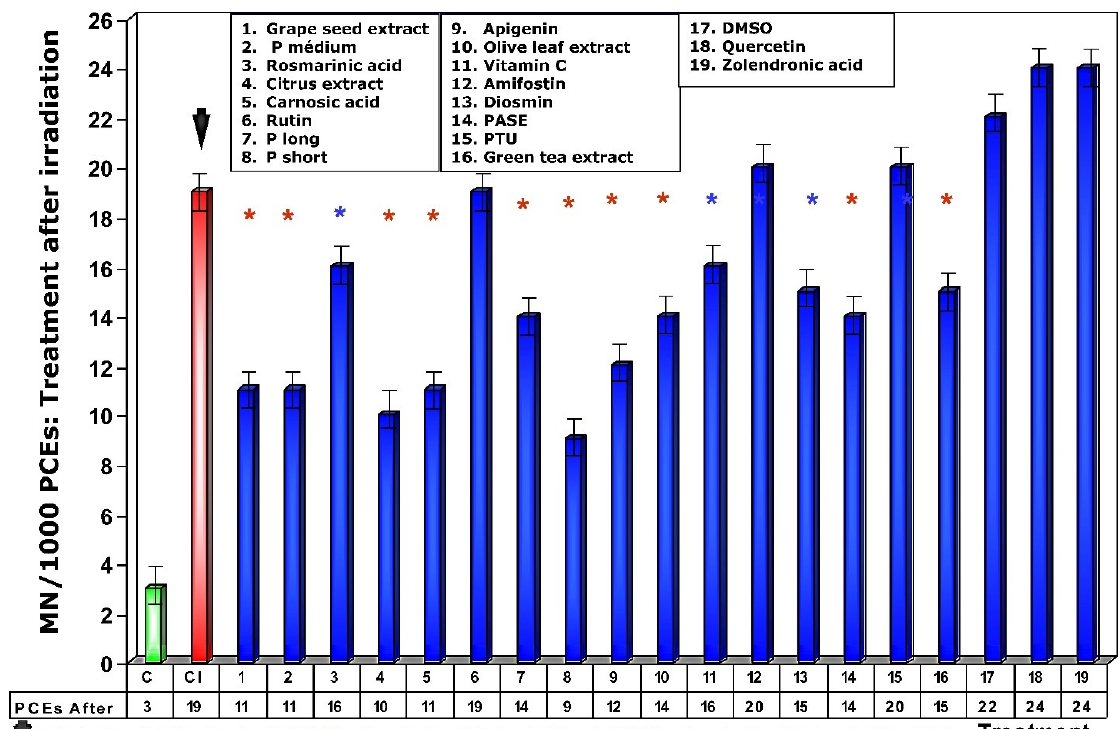
Figure 6. Frequency of micronuclei in polychromatic erythrocytes treated with test substances im- mediately after exposure to ionizing radiation.